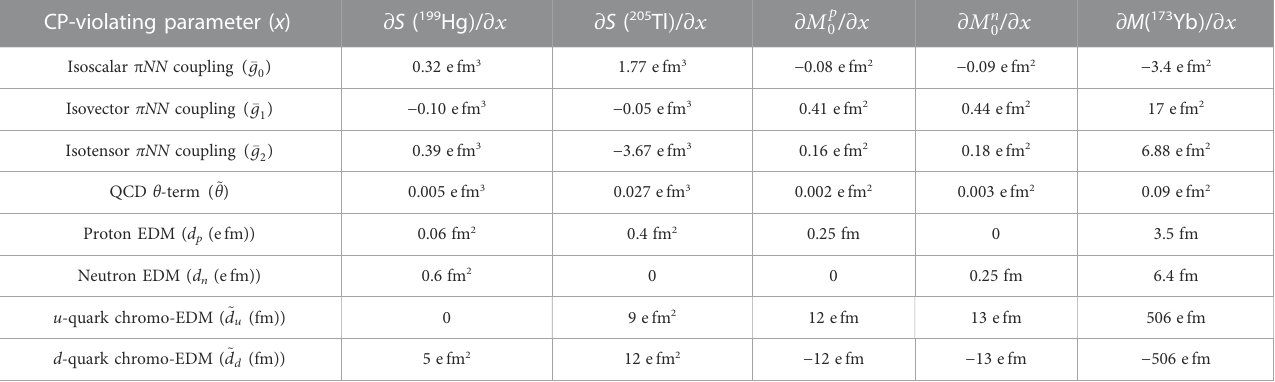
TABLE 3 The dependence of the Schiff moments of 199 Hg and 205 Tl [36], nucleon MQMs and the MQM of 173 Yb [19] on CP-violating parameters. The dependence of M ( 173 Yb)iscalculatedfromtheenhancementofnucleonMQMsasgiveninTable1.Throughout,wetakethestrong π -mesonnucleon-nucleoninteractionconstanttobe g = 13.6